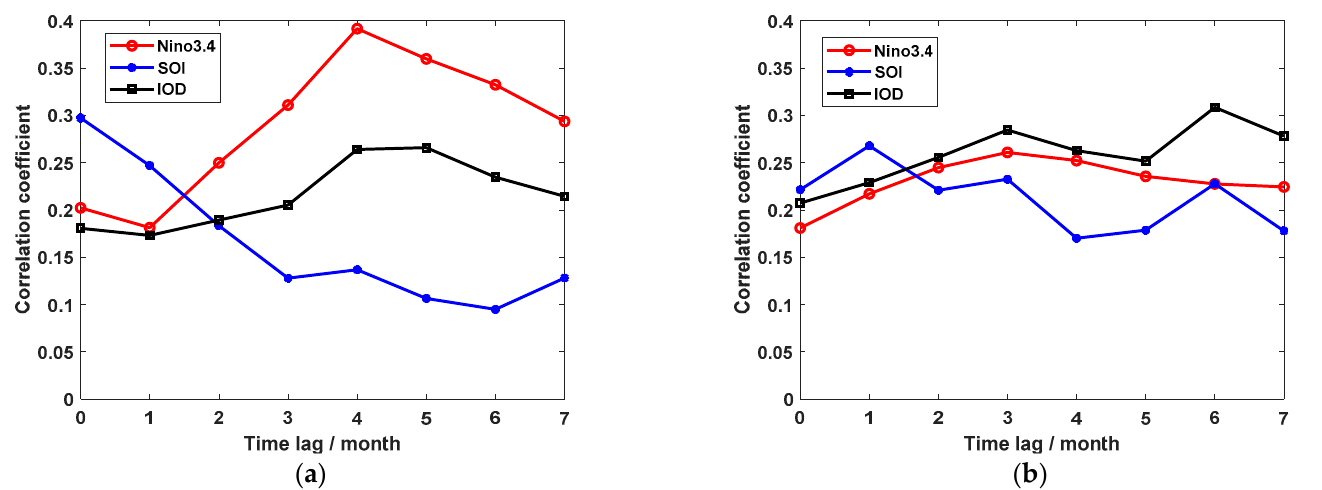
Figure 8. The mean amount of correlation coefficients between TSDI and drought driving factors over mainland Australia during ( a ) Drought 2006–2009; ( b ) Drought 2018–2020 . Table 5. The maximum mean absolute correlation coefficients and the lagging times between TSDI and climate indices (Nino3.4, SOI and IOD) for the two droughts (unit of lagging time: months). Nino3.4